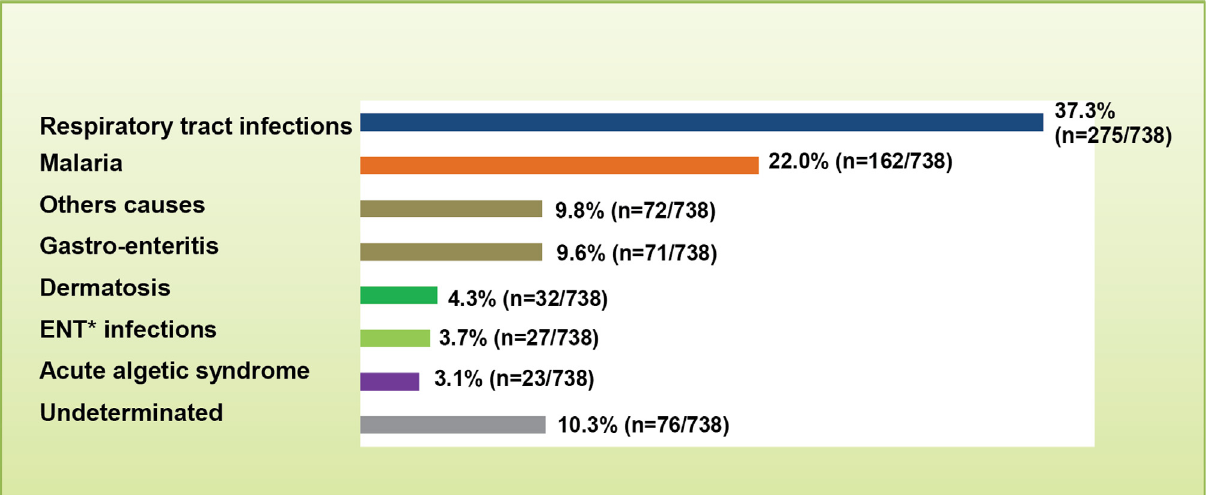
Figure 1. Distribution of certain fever diseases diagnosed in the children included in the study. *Ear, nose, and throat infections.